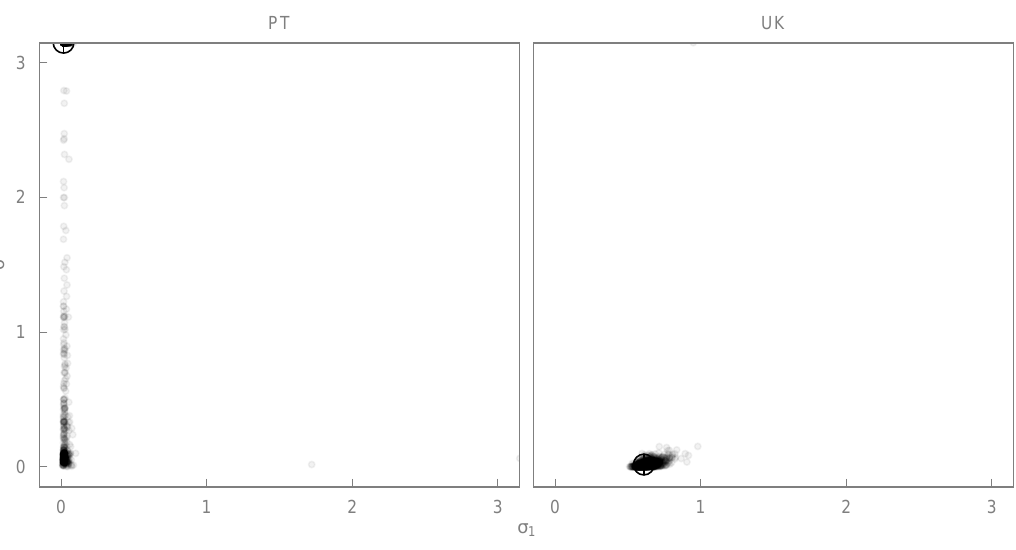
Figure 10. Bootstrap resampling distribution for ˆ σ and ˆ σ 1 for resampled CES models that reject the CSP, include energy, use quality-adjusted factors of production, and employ the ( kl ) e nesting. Parameter estimates from the original data (ˆ σ and ˆ σ 1 ) are shown as crosshairs ( ⊕ ). Each dot ( • ) represents parameter estimates from one of the 1000 resampled data sets. 95% transparency is used so that twenty coincident dots will appear